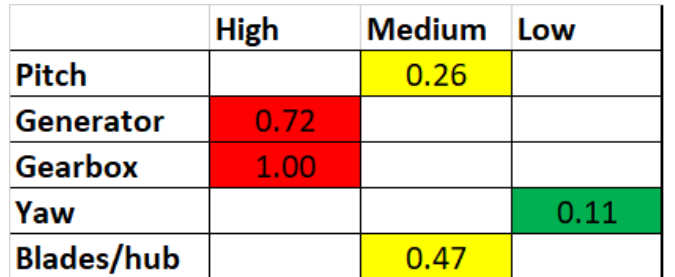
Figure 12. Severity risk matrix of normalised failure rates times downtime rates for pitch, generator, gearbox, yaw and blade/hub in an offshore HAWT wind farm, as computed from box plots of Figures 10 and